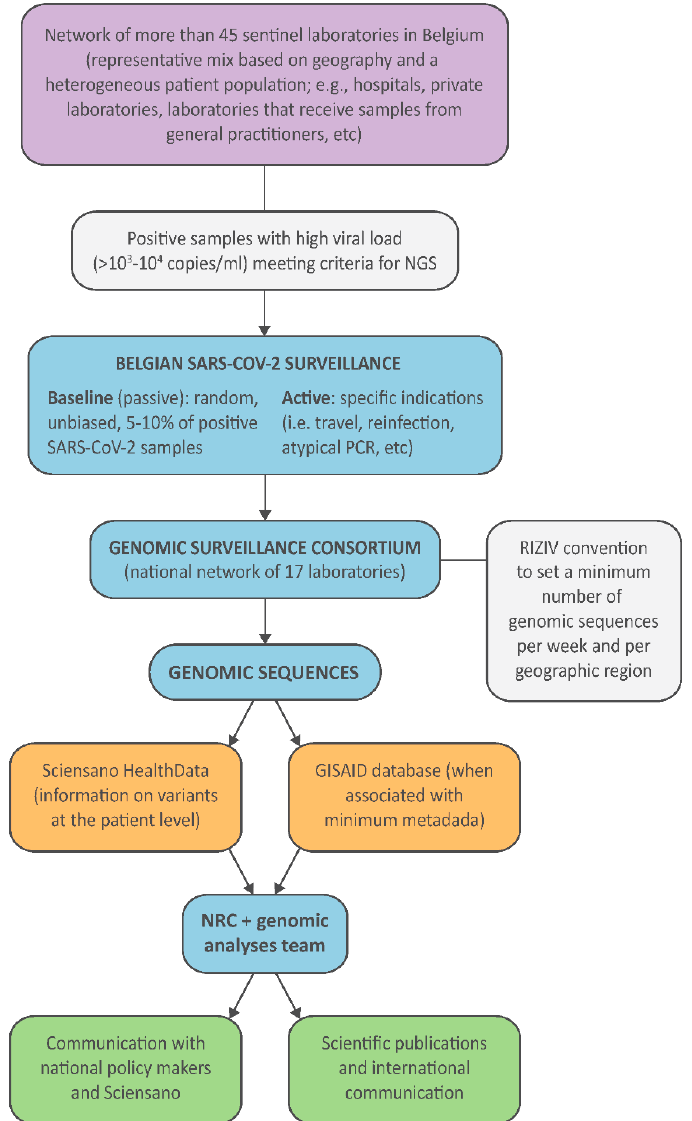
Figure 3. Workflow of the SARS-CoV-2 genomic surveillance established in Belgium. “NRC” stands for National Reference Center (and in this context refers to the NRC for respiratory pathogens), “RIZIV” for National Institute for Health and Disability, and “NGS” for next-generation sequencing. The year following the start of the nationwide genomic surveillance initiative in Belgium saw an important increase in the sequencing coverage of positive cases, rising from 1% to nearly 4% (Figure 4). While the initial sequencing coverage of positive cases of 1% already put Belgium at a recently proposed threshold/benchmark for rapidly detecting circulating SARS-CoV-2 variants through random sampling, this increase put Belgium closer towards ensuring the rapid detection of viral lineages, according to a recent simulation study [28]. This increase puts Belgium just below several other European countries in terms of coverage of positive cases, including Germany, Austria, Norway, and Finland, but ahead of the Netherlands, France, Portugal, and Spain. Of note, this sequencing coverage of positive cases has been highly variable throughout the pandemic, directly related to the number of cases associated with the different pandemic waves of infections. During times when there has been a relatively low number of infections,